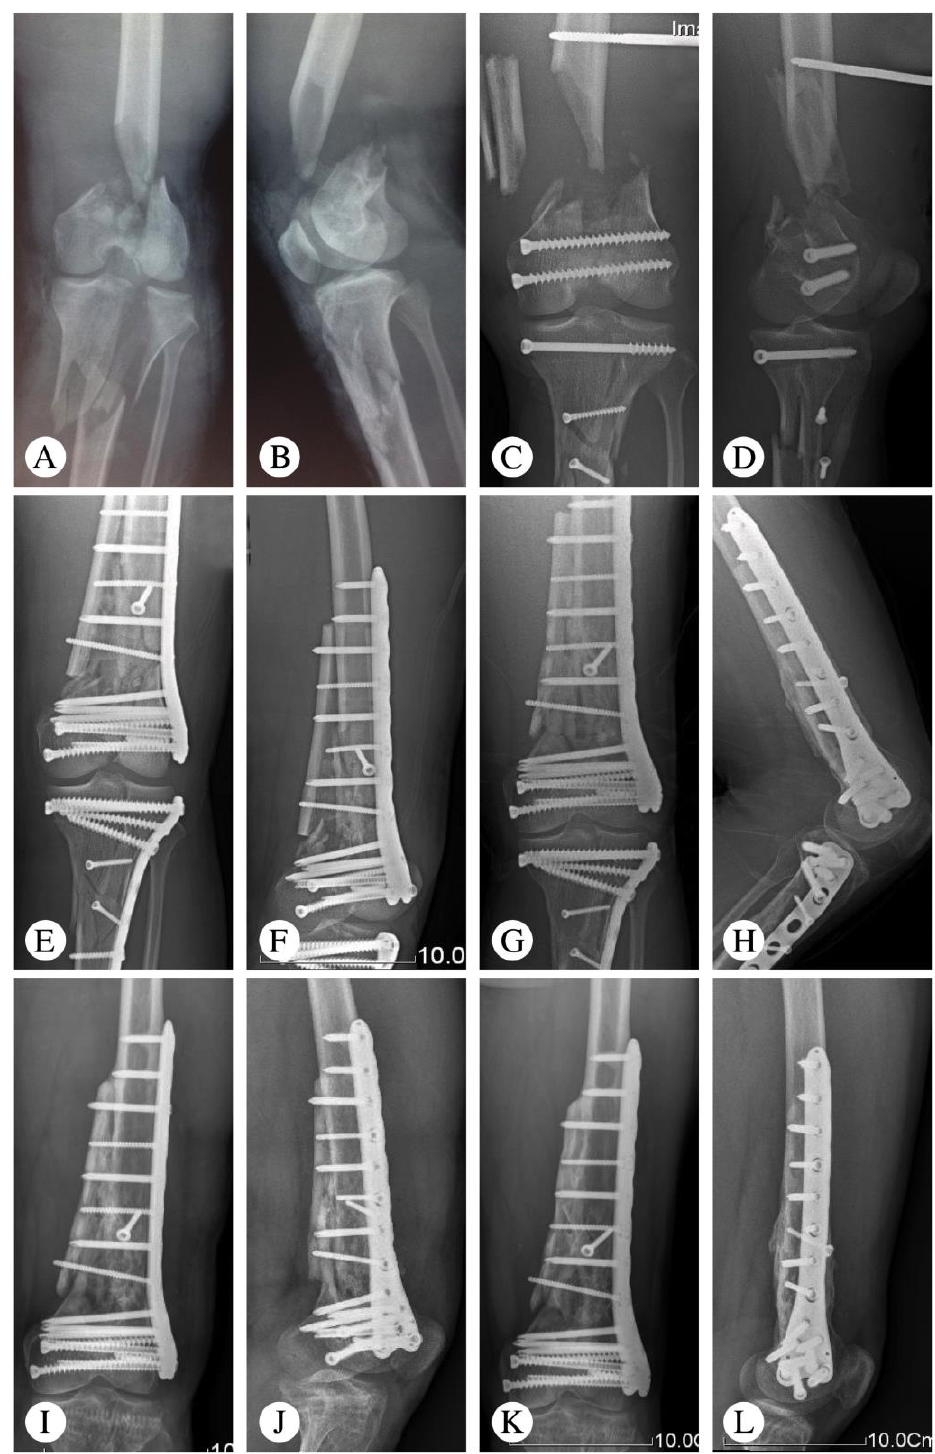
Figure 3. Representative images of Patient 10 (21-year-old male patient with a Gustilo IIIB fracture resulting from a traffic accident). ( A , B ) X-ray at admission. ( C , D ) X-ray after emergency operation. Limited internal fixation combined with external fixation was utilized. ( E , F ) X-ray 3 months after an interfixation operation. ( G , H ) Follow-up X-ray at 9 months. ( I , J ) Follow-up X-ray at 12 months. Removal of the tibial implant. ( K , L ) Follow-up X-ray at 69 months.